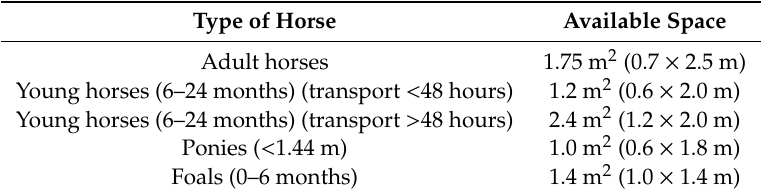
Table A5. Required space per horse for road transport in Europe [7,43].